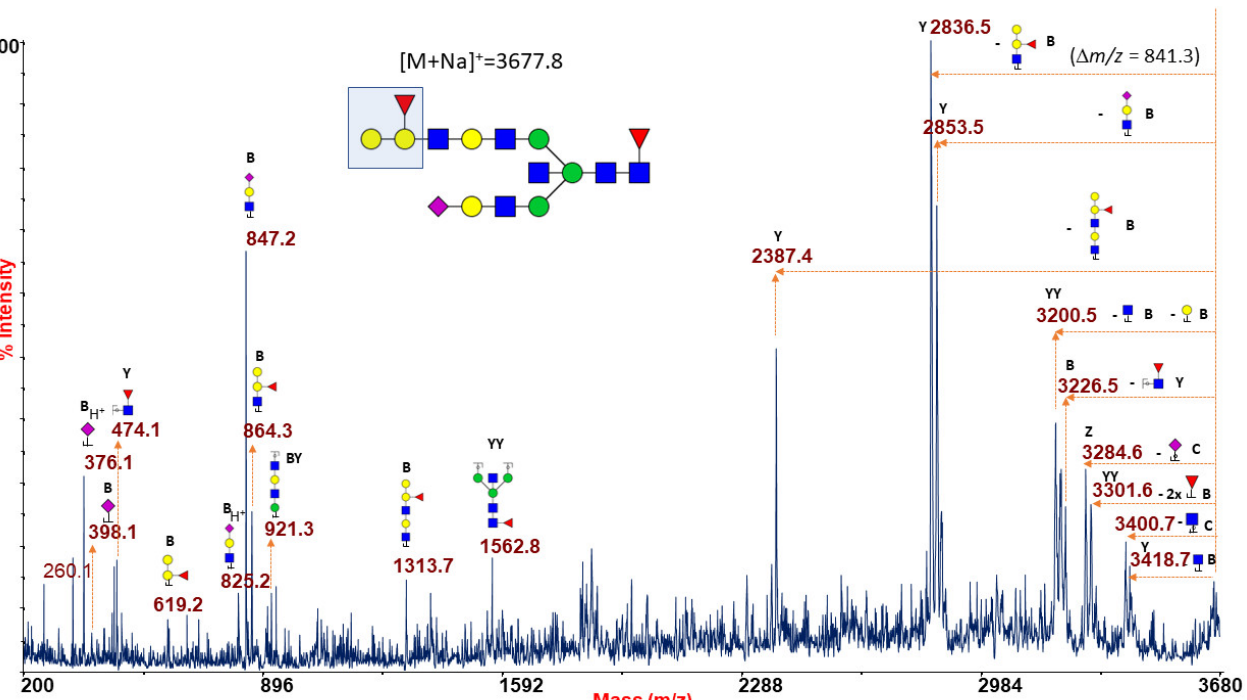
Figure 3. MALDI TOF/TOF MS/MS characterization of the N-glycan precursor at m/z 3677.8 from blood group B human erythrocytes. All the fragmentation pattern points to delineate a N-linked glycan moiety with a terminal blood group B epitope (sketched in the reported structure), as mainly revealed by B-type ions at m/z 619.2, 864.3, and 1313.7; by the predominant Y ion at 2836.5 (m/z 841.3 u from the parent ion); and by a further Y ion at m/z 2387.4. GlcNAc, blue square; Man, green circle; Gal, yellow circle; NeuAc, purple lozenge; Fuc, red triangle.